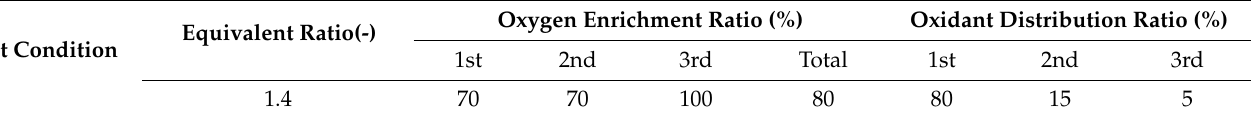
Table 2. Pilot plant test experimental